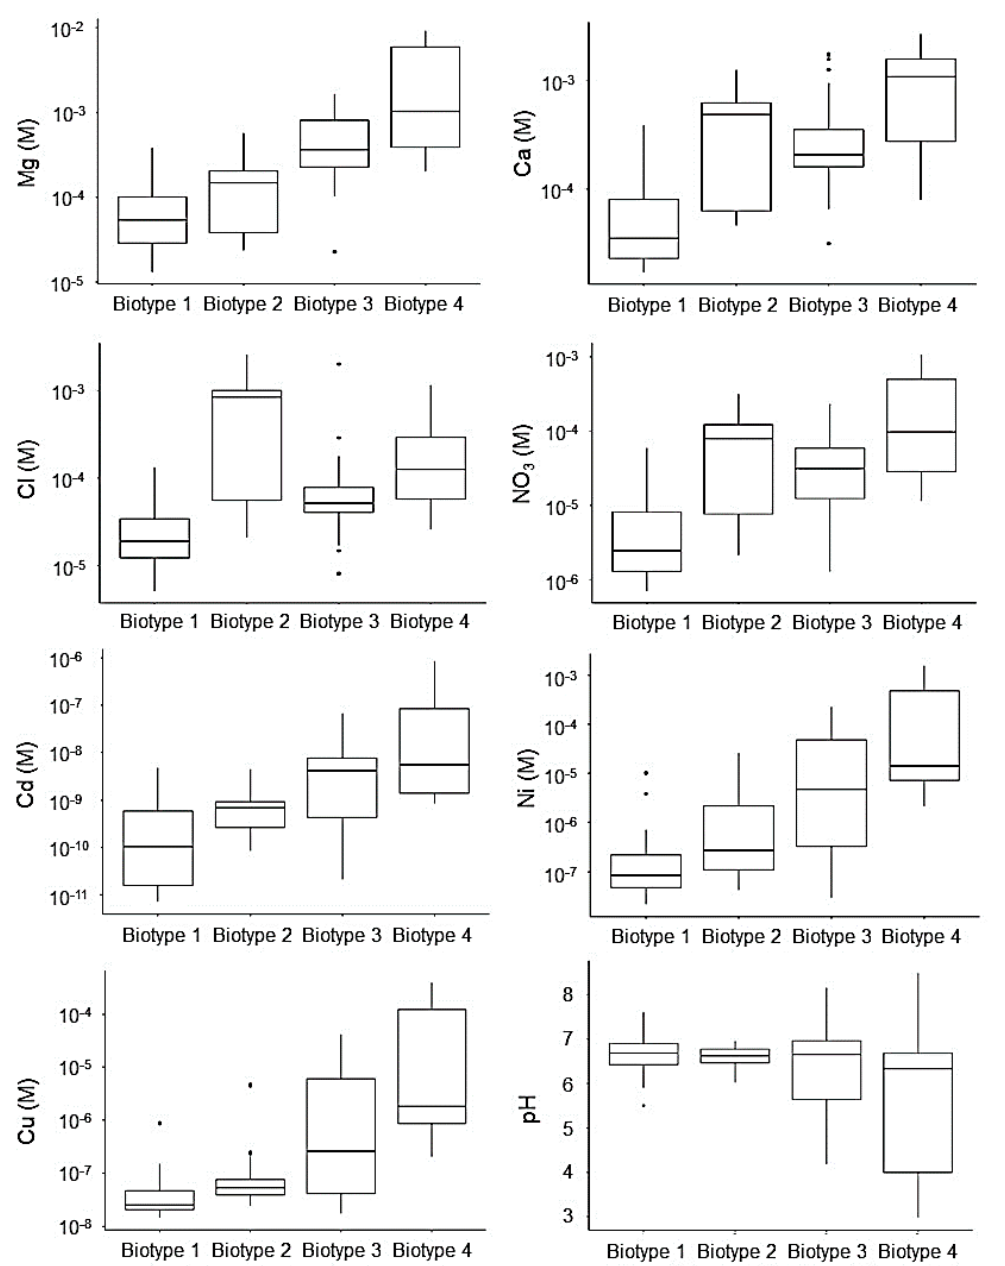
Figure 3. Box-plots showing the distribution of water chemistry data for each biotype. Data (except pH) are presented on a log10